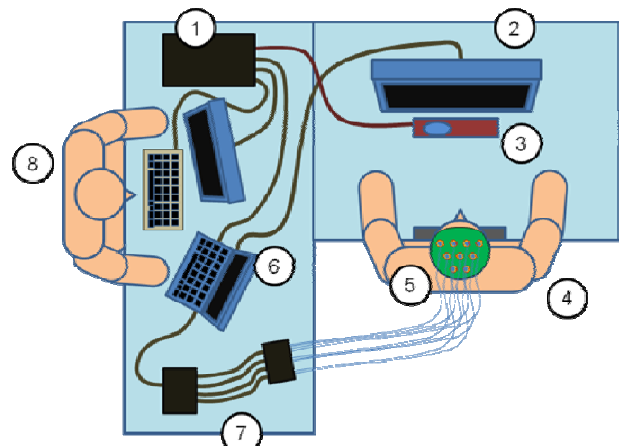
Figure 1. Setup Example: (1) Eye-tracker Host Computer, (2) Eye-tracker Display Monitor, (3) Eye-tracker sensing device, (4) User, (5) EEG Head Cuff, (6) Display PC, (7) EEG Amplifier, (8) Operator Brain Computer